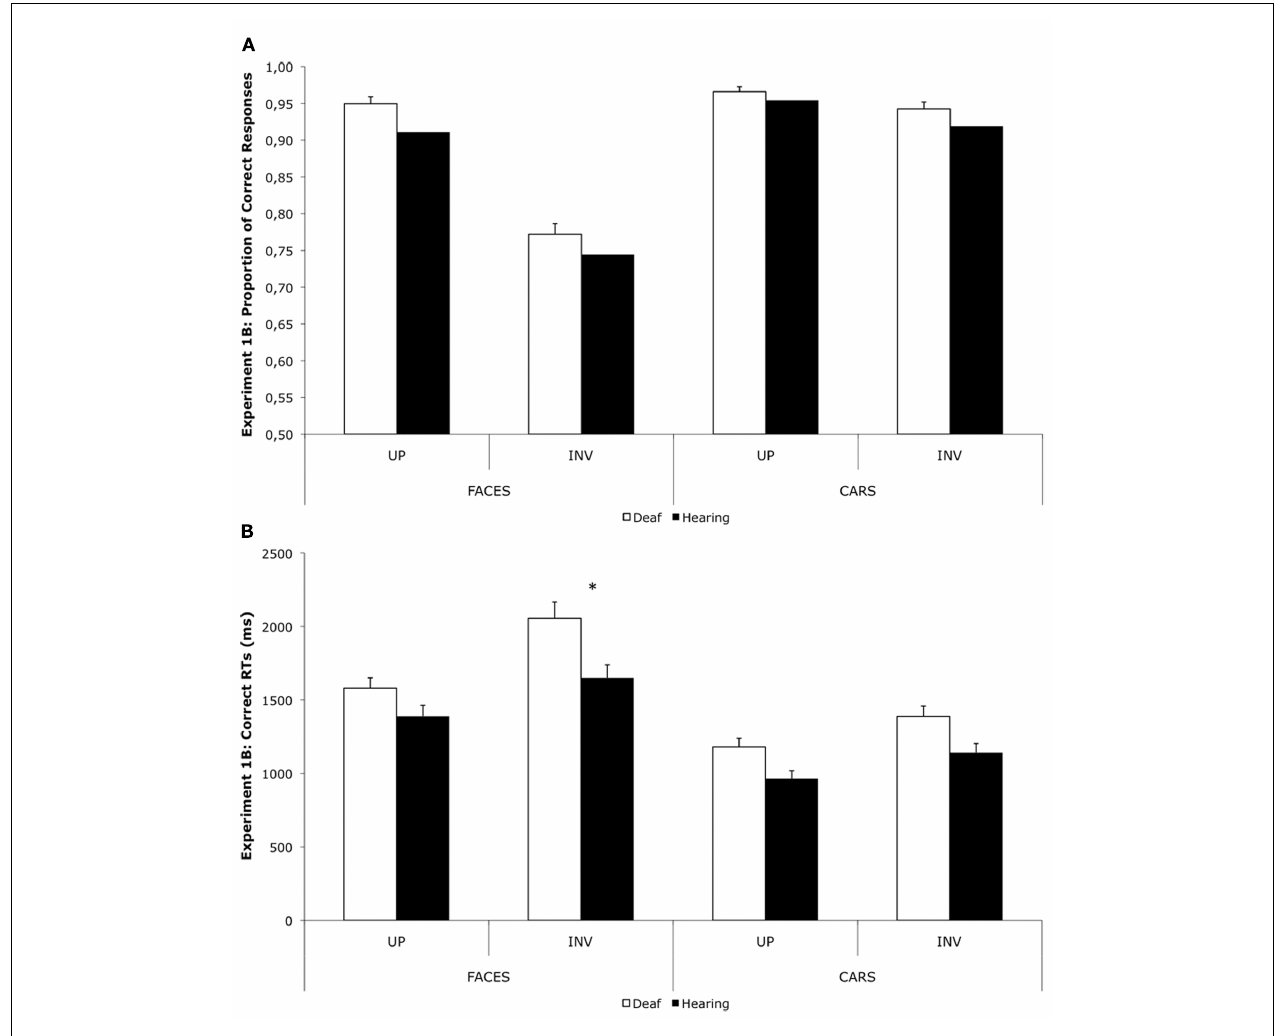
delay between the target and the probes (Experiment 1B). Bars represent SEs. Asterisks indicate significant differences between the two groups ( p <